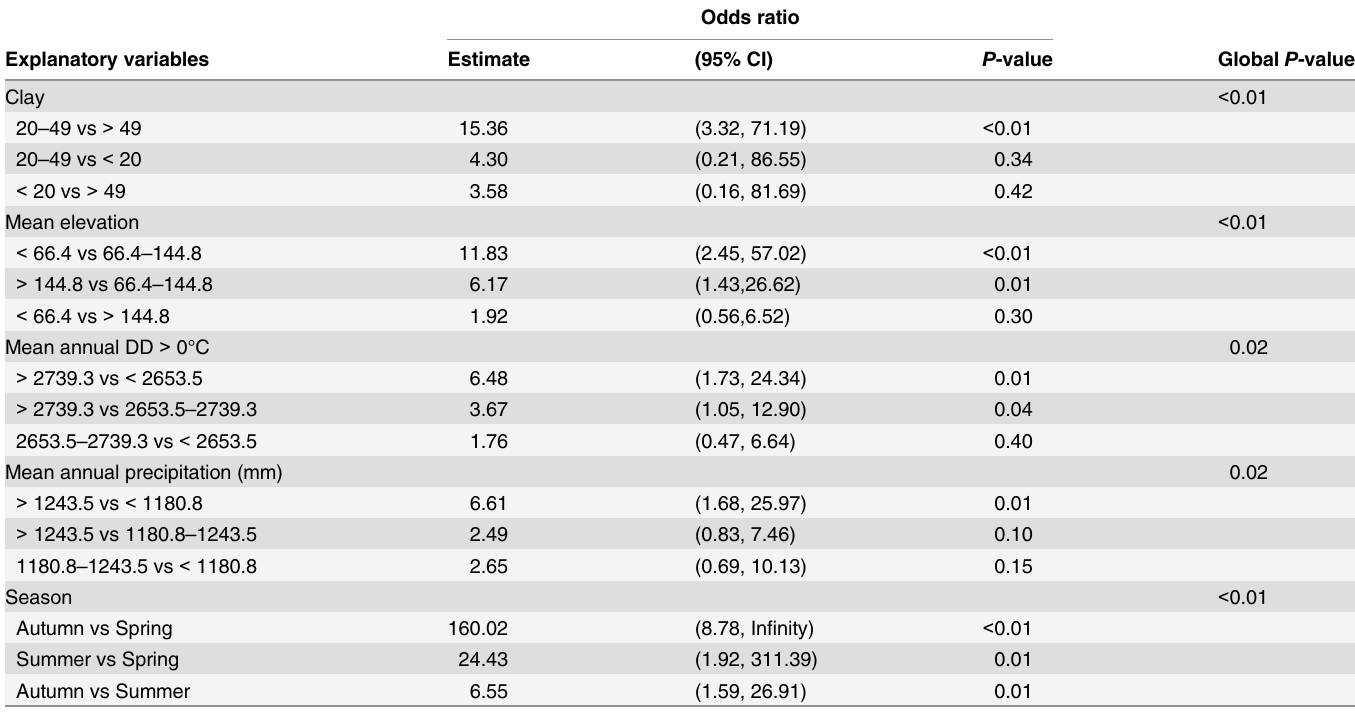
Table 3. Final multivariable logistic regression model for predicting occurrence of H . leporispalustris